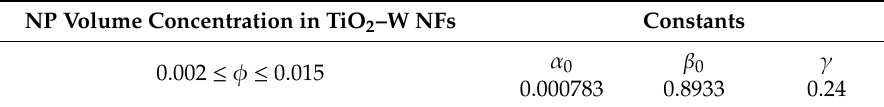
Table 2. Constant values of Equation (13).